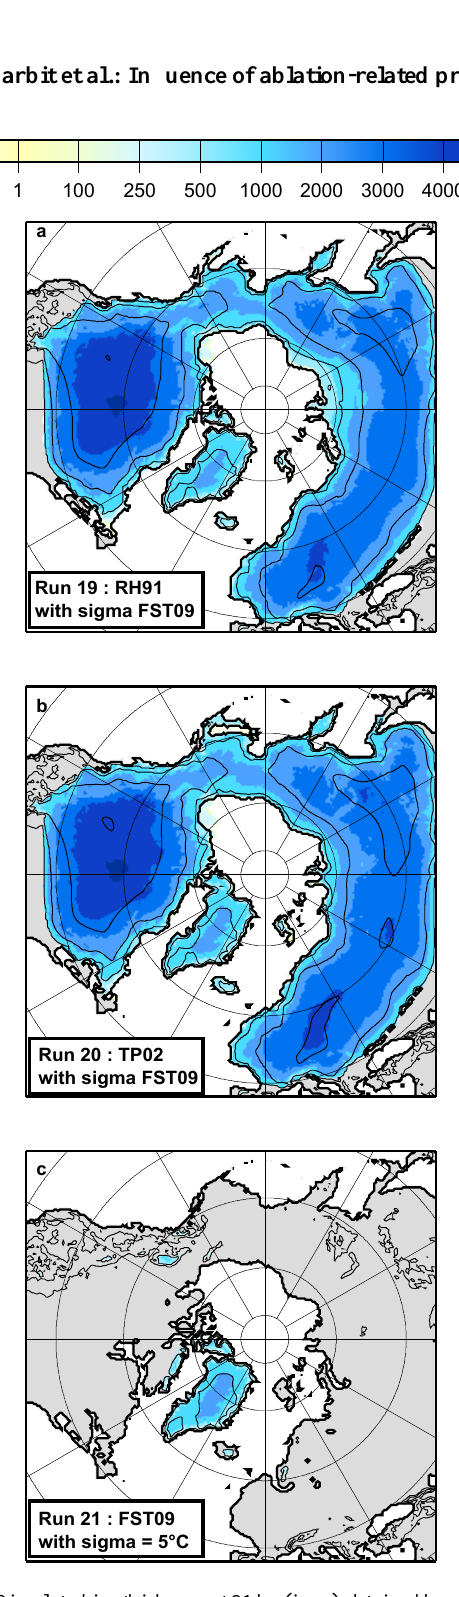
Fig. 5. Simulated ice thickness at 21ka (in m) obtained by substitut- ing the FST09 σ altitude relationship in RH91 ( a , run 19) and TP02 ( b , run 20) models, and when using a fixed ( = 5.0 ◦ C) σ value in the FST09 model ( c , run